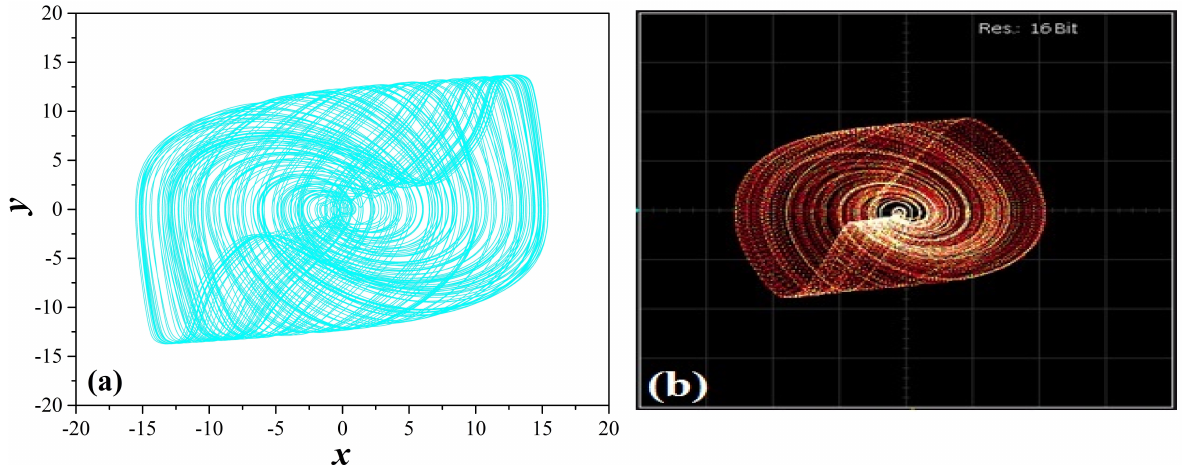
Figure 5. Chaotic phase portraits of y versus x , for a = 4 × 10 − 4 , c = 3.846 × 10 − 4 , d = e = 1 and b = 0.625 ( R b = 16 k Ω ) , produced ( a ) from system’s (2) simulation and ( b ) experimentally from the circuit of Figure